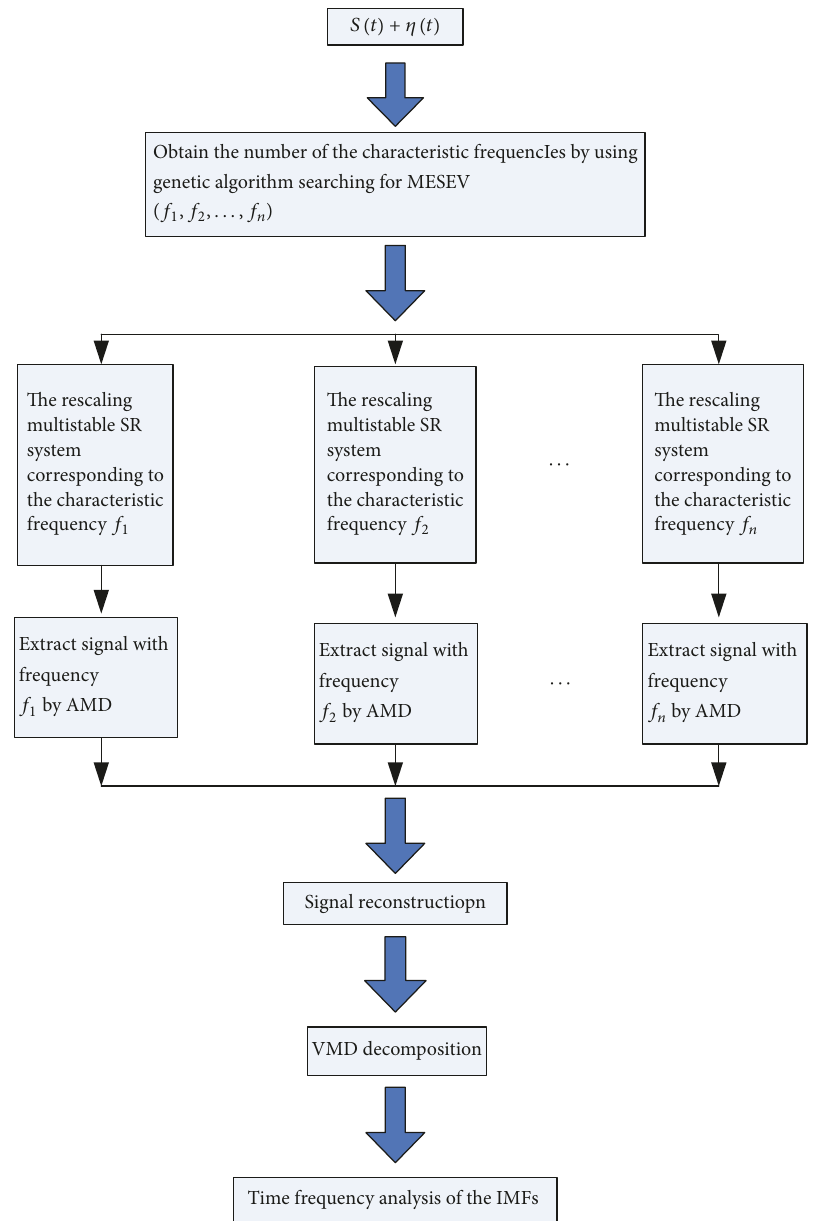
Figure 8: The flow process diagram of proposed